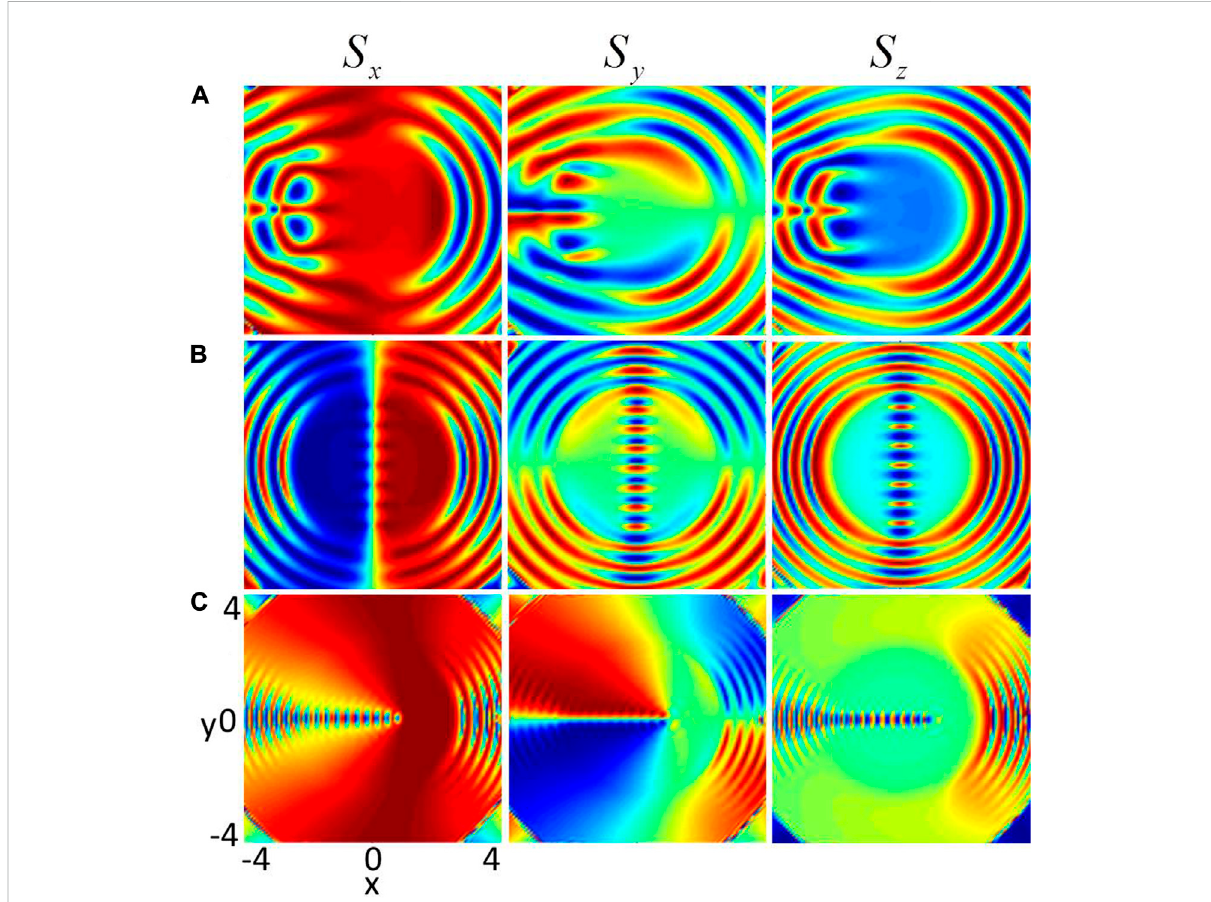
FIGURE 4 (Color online) Spin densities of dipolar BECs with D-SOC in an anharmonic trap. (A) ε dd = 5, k = 3, (B) ε dd = 5, k = 5 and (C) ε dd = 5, k = 9. The corresponding ground states in (A) , (B) and (C) are presented in Figure 2E, Figure 3E and Figure 3F. The columns from left to right are spin density S x , S y , S z , respectively. The unit length is a 0